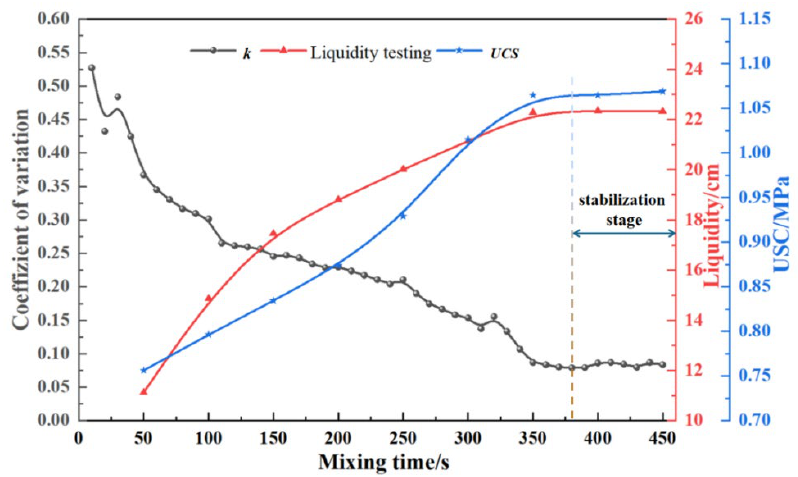
Figure 10. Homogeneity versus backfilling performance.